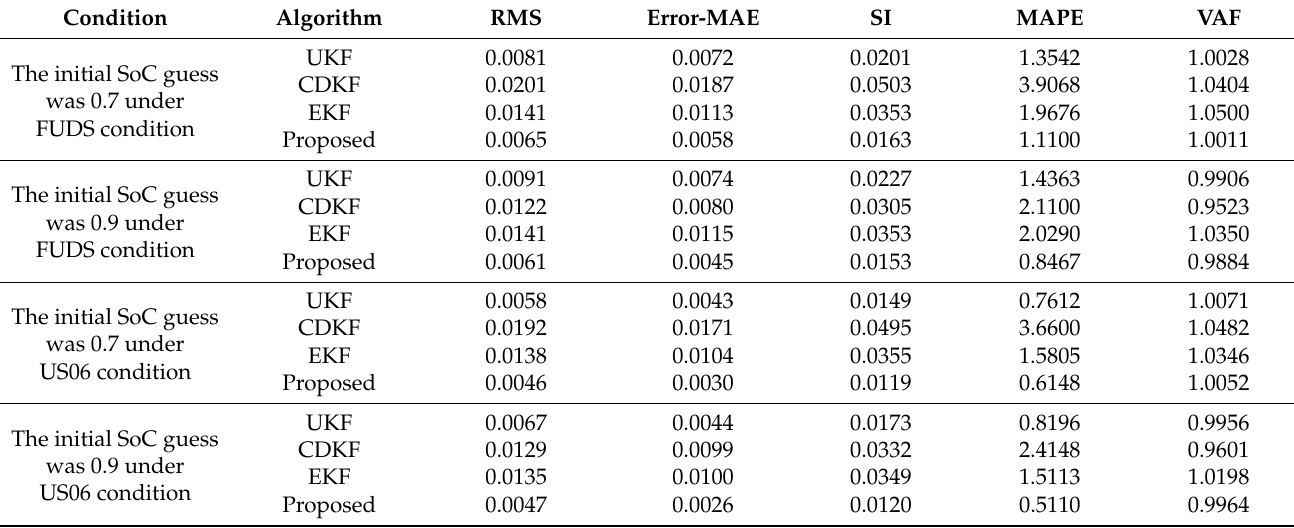
Table 6. Comparison of SoC estimation errors of four algorithms.